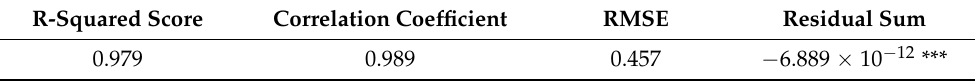
Table 5. Statistical comparison of canopy temperatures from model and measurements.